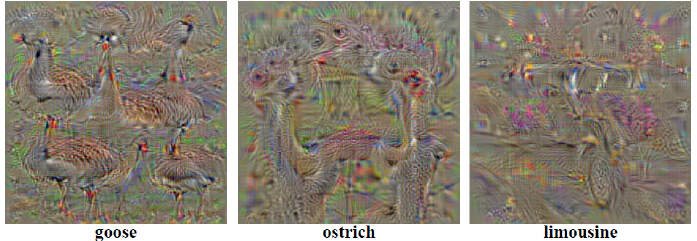
Figure 8. Deep inside convolutional networks [59]: created input images that have the highest probability of being predicted as certain classes of a trained CNN. Here, one can see the created prototypes of the classes goose, ostrich, and limousine ( left to right ).